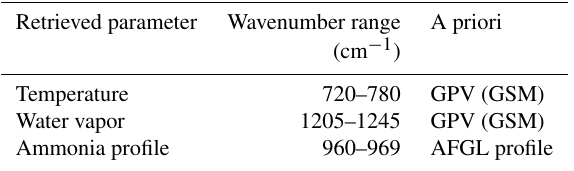
Table 1. Wavenumber range and a priori information used in the retrieval